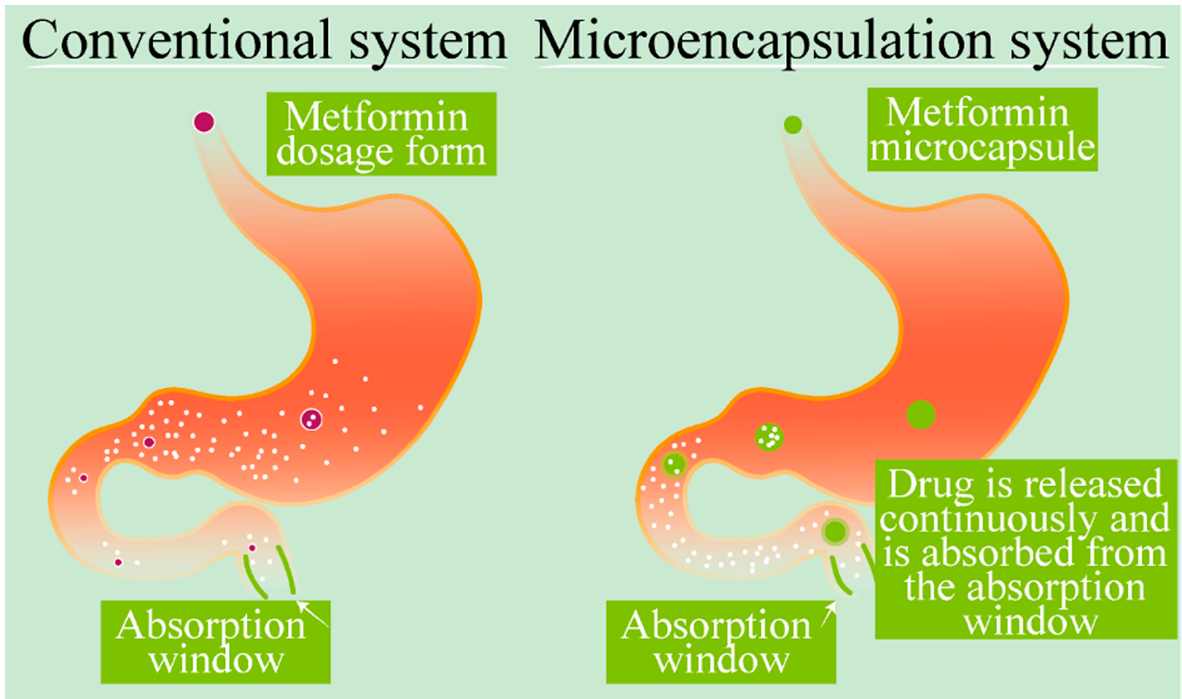
Figure 4. Metformin delivery: conventional versus microencapsulation. Demonstration of a traditional metformin dosage form showing large drug release prior to the absorption window. In comparison, microencapsulation of metformin retains the drug to allow a continuous release to the absorption